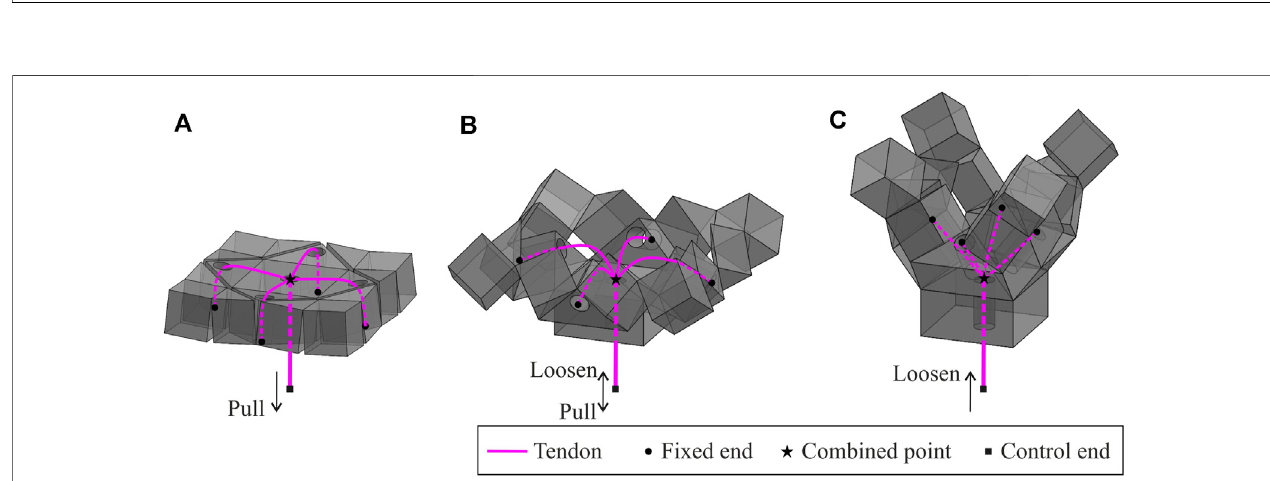
FIGURE 3 | Tendon routings of the assembly and the motions passing through (A) the partially folded state, (B) the semi-folded state, and (C) the near fully folded state. This provides the foundation for grasping behaviour, which is repeatable by pulling and releasing the control end of tendons.